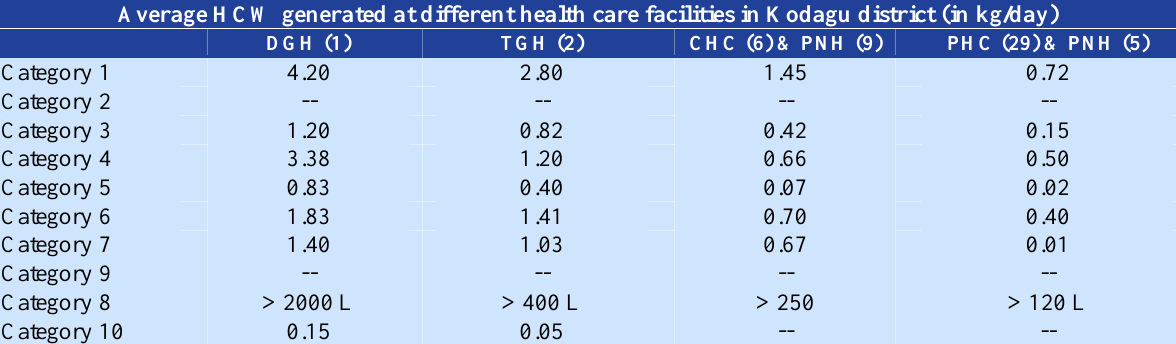
Table 1. Categories of healthcare wastes (HCW) quantitative generation per day at different level health care facilities in Kodagu